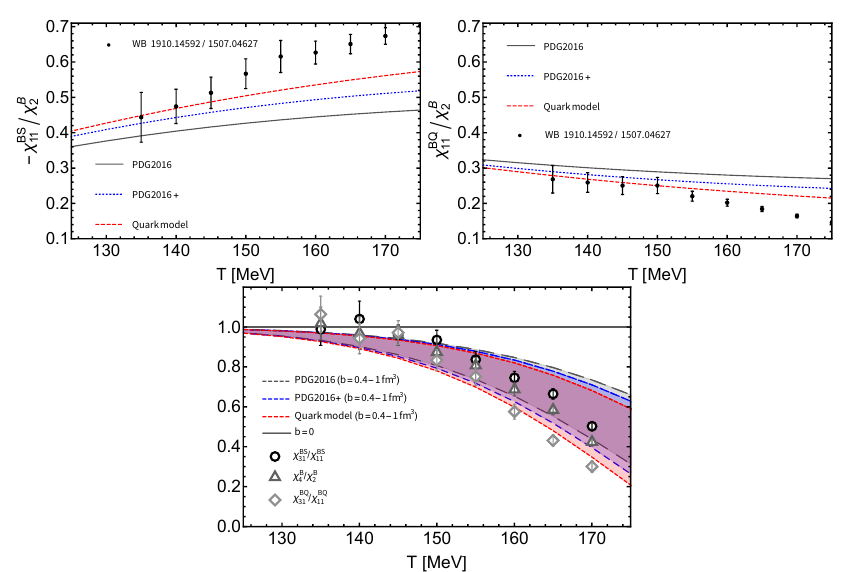
Figure 1. Temperature dependence of susceptibility ratios in the EV-HRG model (colored lines) and from Lattice QCD (grayscale points). Top: second order susceptibility ratios insensitive to the excluded volume parameter b . Bottom: fourth-to-second order susceptibility ratios, insensitive to the hadron spectrum. Here the colored bands correspond to a range of b : 0 . 4